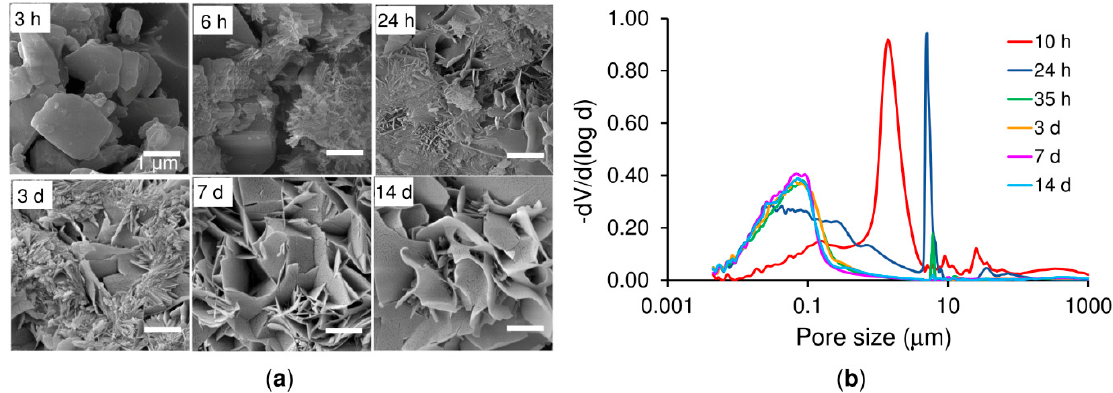
Figure 6. Microstructure and porosity development of the cement samples prepared at an L/P ratio of 0.5 g · g − 1 , α -TCP mixed with 20 w / v % of the copolymer at different reaction times at 37 ◦ C. ( a ) Representative SEM images of the fracture surface for α -TCP pastes after 3 h, 6 h, 24 h, 3 d, 7 d and 14 d of reaction. The scale bar is 1 µ m in all cases. ( b ) Pore size distribution during a reaction time from 10 h to 14